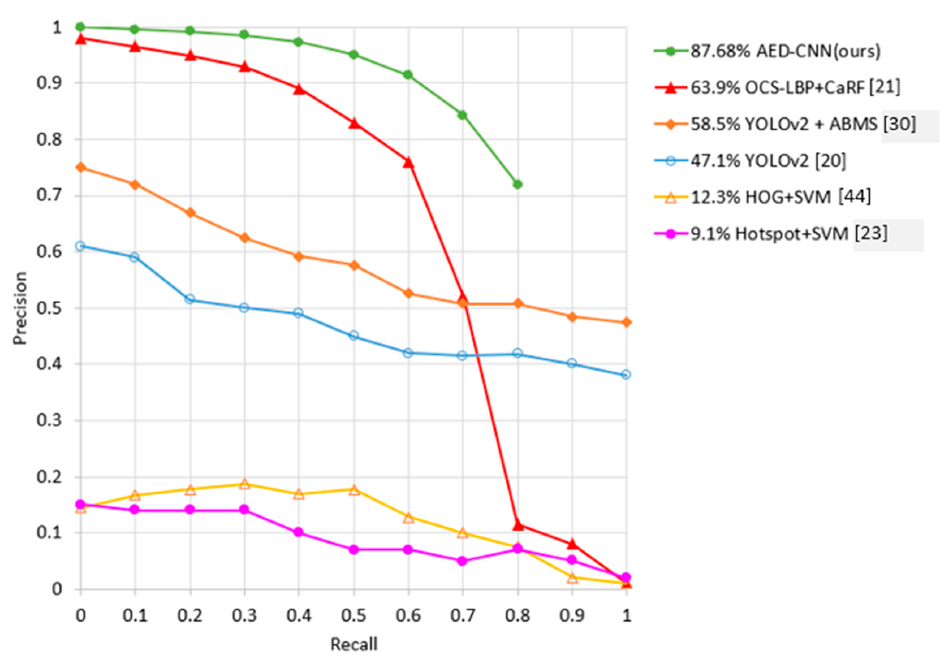
Figure 7. Performance comparison of precision versus recall by using the Computer Vision Center (CVC)09 dataset.